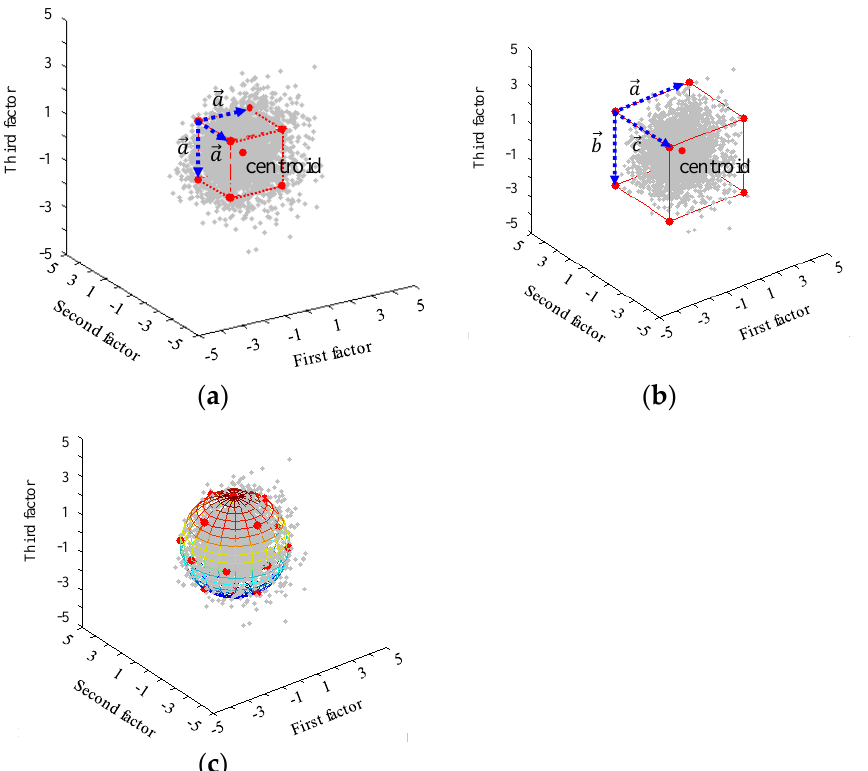
Figure 1. Multivariate generation methods of representative humanoids (RHs). Small dots: Anthro- pometric cases of a target population; large dots: RHs; dashed lines: Accommodation boundaries. ( a ) Square method; ( b ) rectangular method; ( c ) circular method.